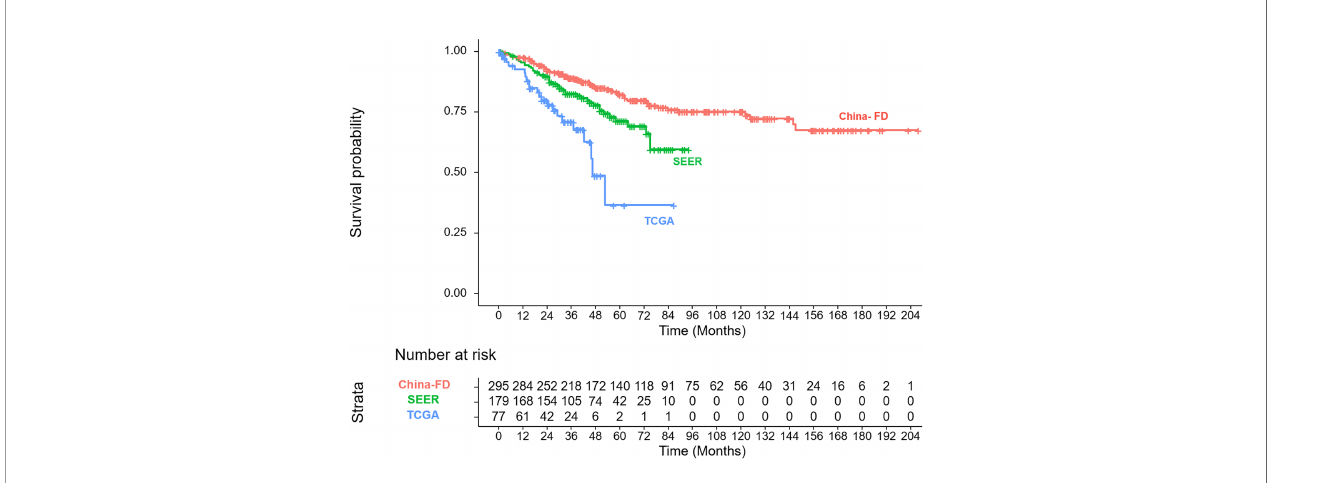
FIGURE 2 | The overall survival curves for the training and validation cohorts.